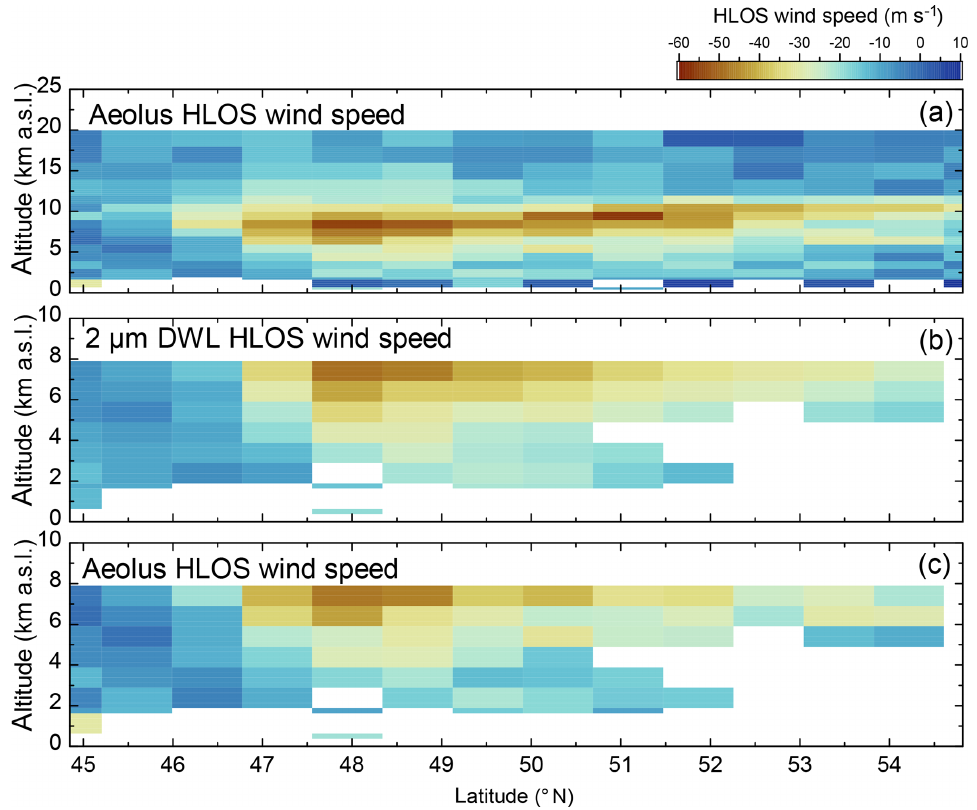
Figure 5. Wind observations obtained during the first leg of the Aeolus underflight on 17 November 2018 between 45 and 55 ◦ N (1146km) in the framework of the WindVal III campaign. (a) Aeolus Rayleigh-clear winds with an estimated error of smaller than 8ms − 1 . (b) Corre- sponding 2µm DWL observations averaged to the Aeolus grid and projected onto its viewing direction. (c) Aeolus Rayleigh-clear winds as shown in (a) in regions where 2µm DWL data are available for